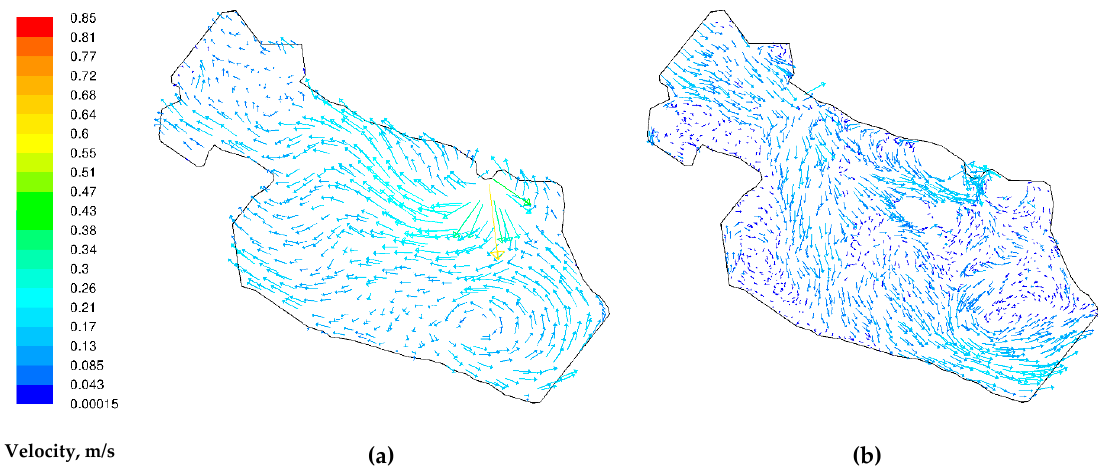
Figure 9. The velocity vector field in the horizontal plane near the surface ( a ) and at a depth of 6 meters ( b ) for the southeasterly wind. The time after the start of calculations is 20 hours.